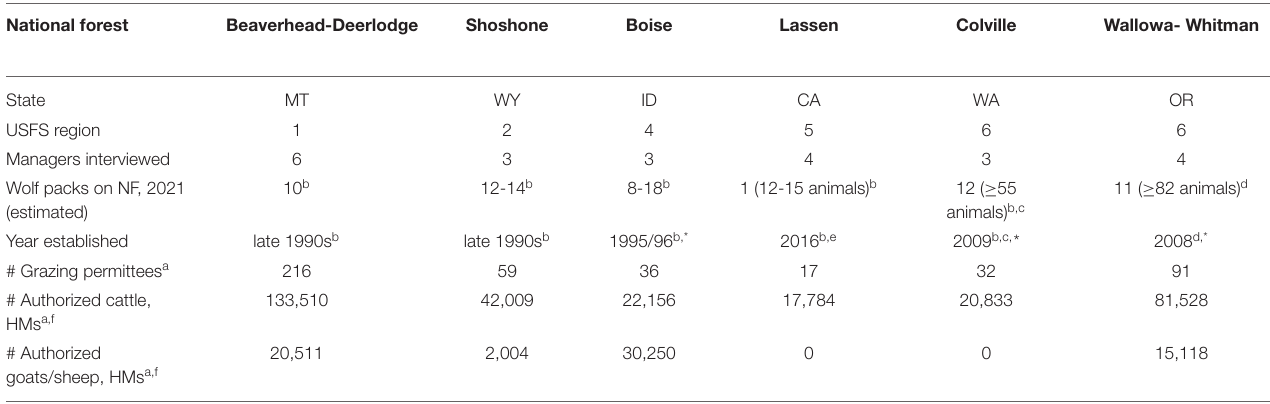
TABLE 1 | Status of wolves and livestock on case-study national forests, 2020–2021. National